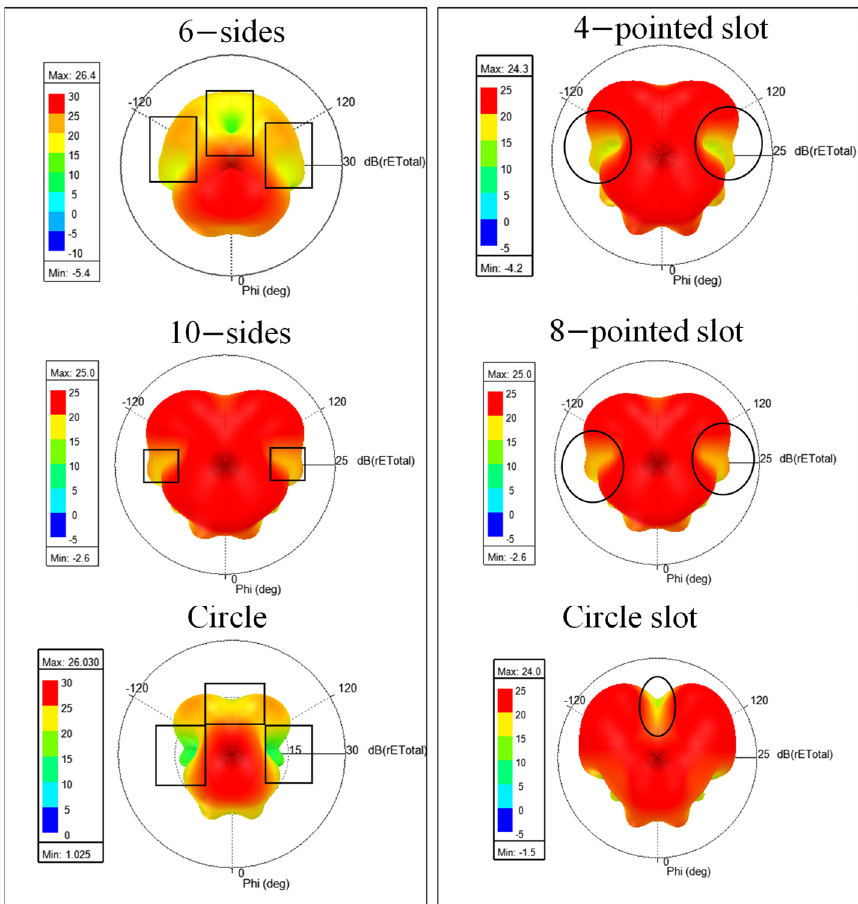
Figure 4. 3D—radiation patterns (in dB) from simulation, at the left—side of different antenna shape, and at the right-side of different slot shape.